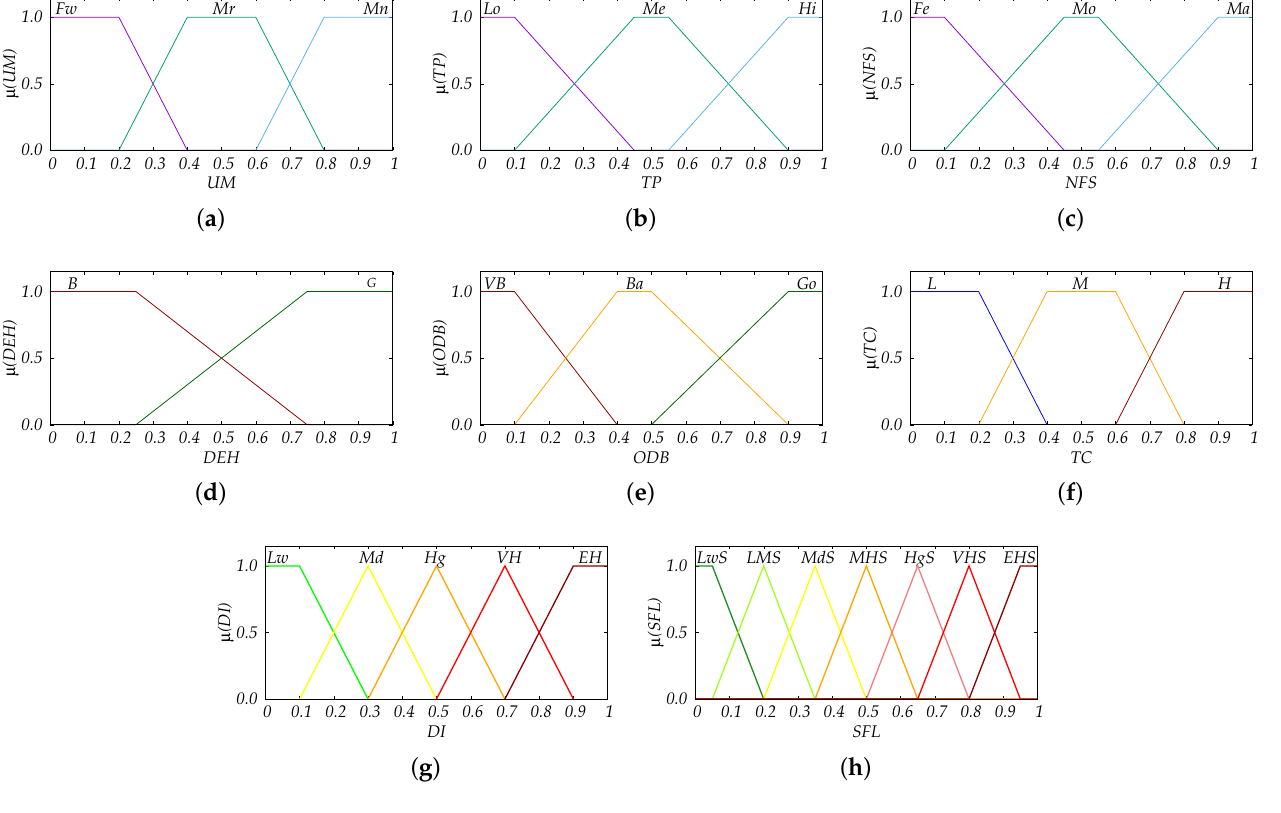
Figure 4. Membership functions of IFSDDS. ( a ) Unnecessary Maneuvers, ( b ) Time Pressure, ( c ) Num- ber of Forced Stops, ( d ) Driving Experience and History, ( e ) Other Drivers’ Behavior, ( f ) Traffic Condition, ( g ) Driver’s Impatience, and ( h ) Stress Feeling